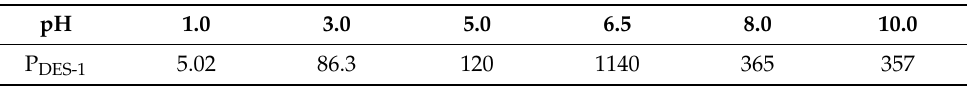
Figure 3. Effect of pH on MB extraction efficiency. [MB] = 200 mg dm − 3 ; T = 25.0 ◦ C. Table 2. The pH dependence of the partition coefficient (P DES-1 ) of MB in TOP-SA. [MB] = 200 mg dm − 3 . T = 25.0 °C .